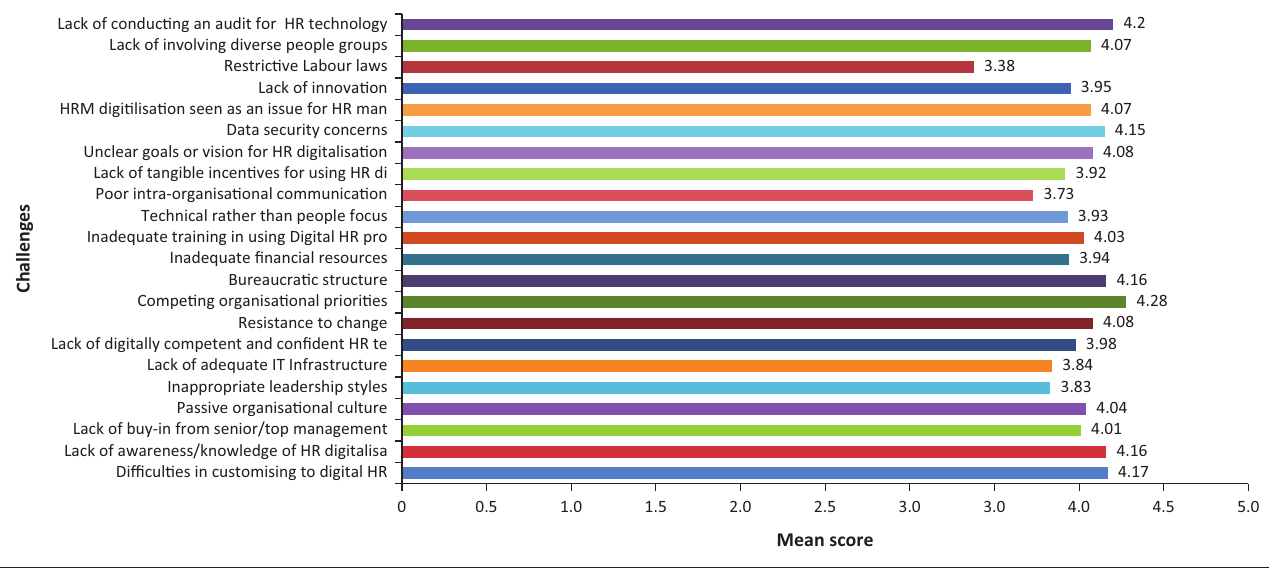
HR, human resource; IT, information and technology. FIGURE 2: Challenges in adopting digital human resource management